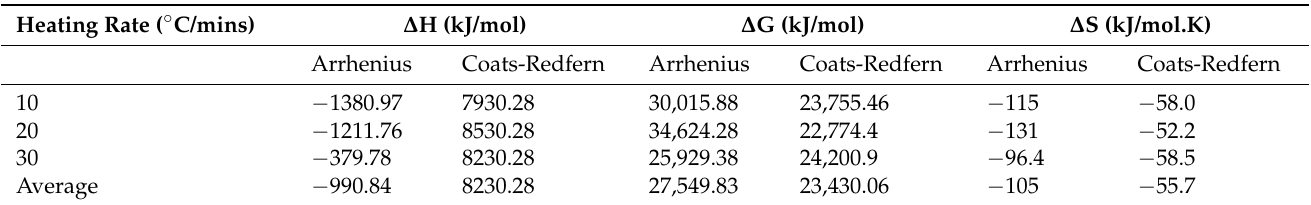
Table 5. Thermodynamic parameters for PET MPs degradation under thermal treatment at different heating